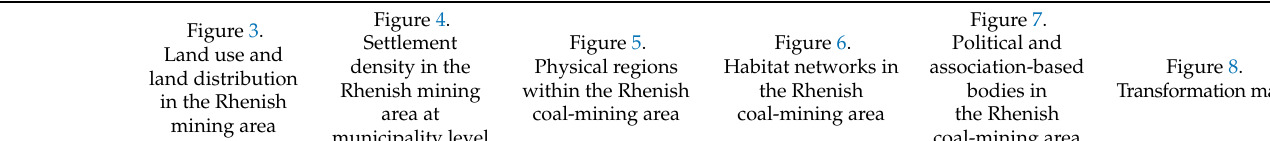
Physical regions within the Rhenish coal-mining area